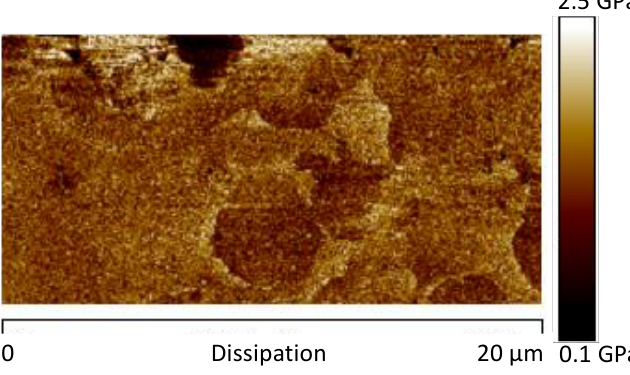
Figure 12. AFM dissipation image of the sample 0GNPs.